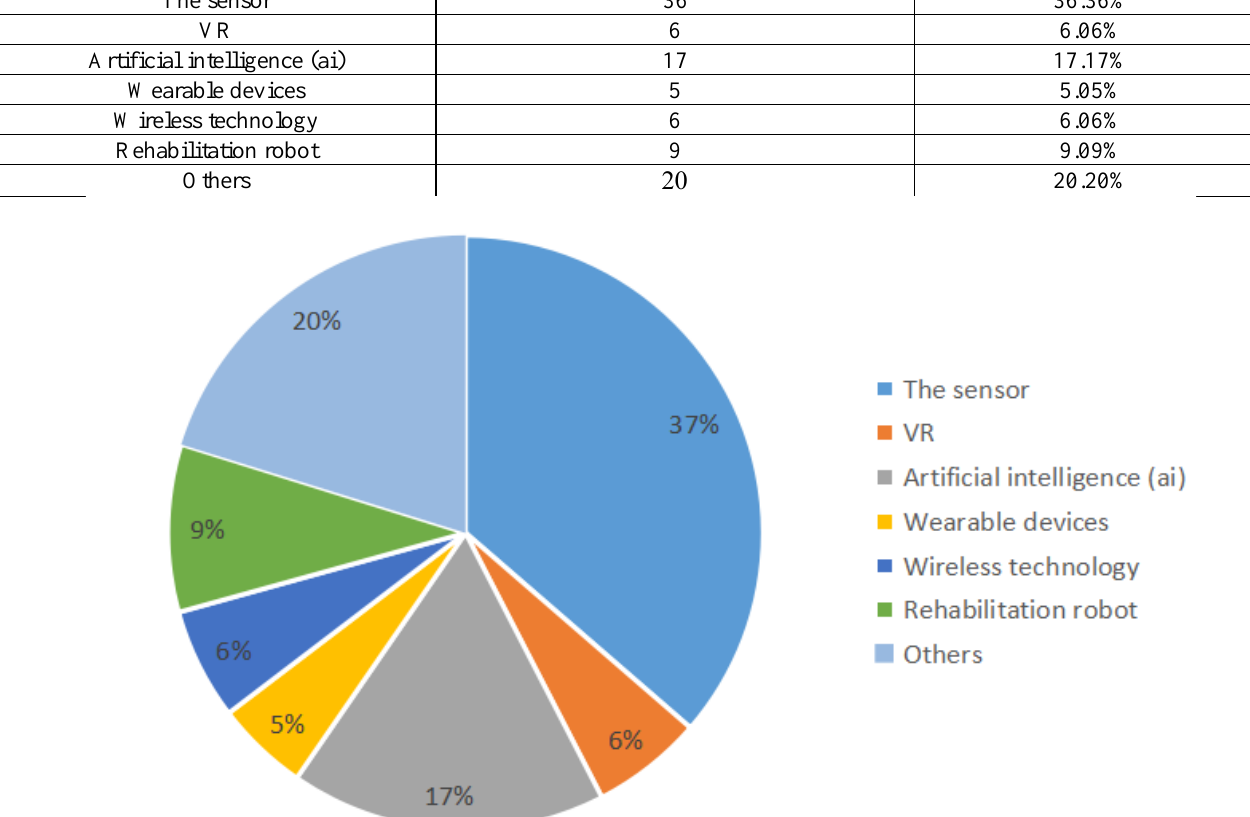
Figure 8. Proportion of IoT technology